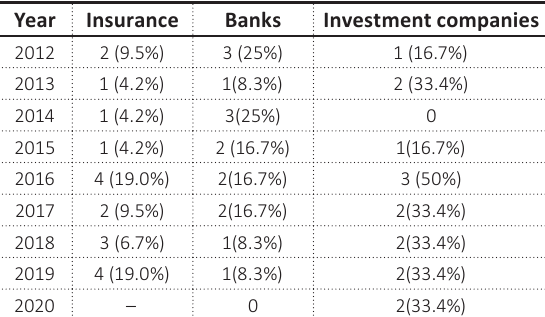
Table 6. Number of efficient companies per year